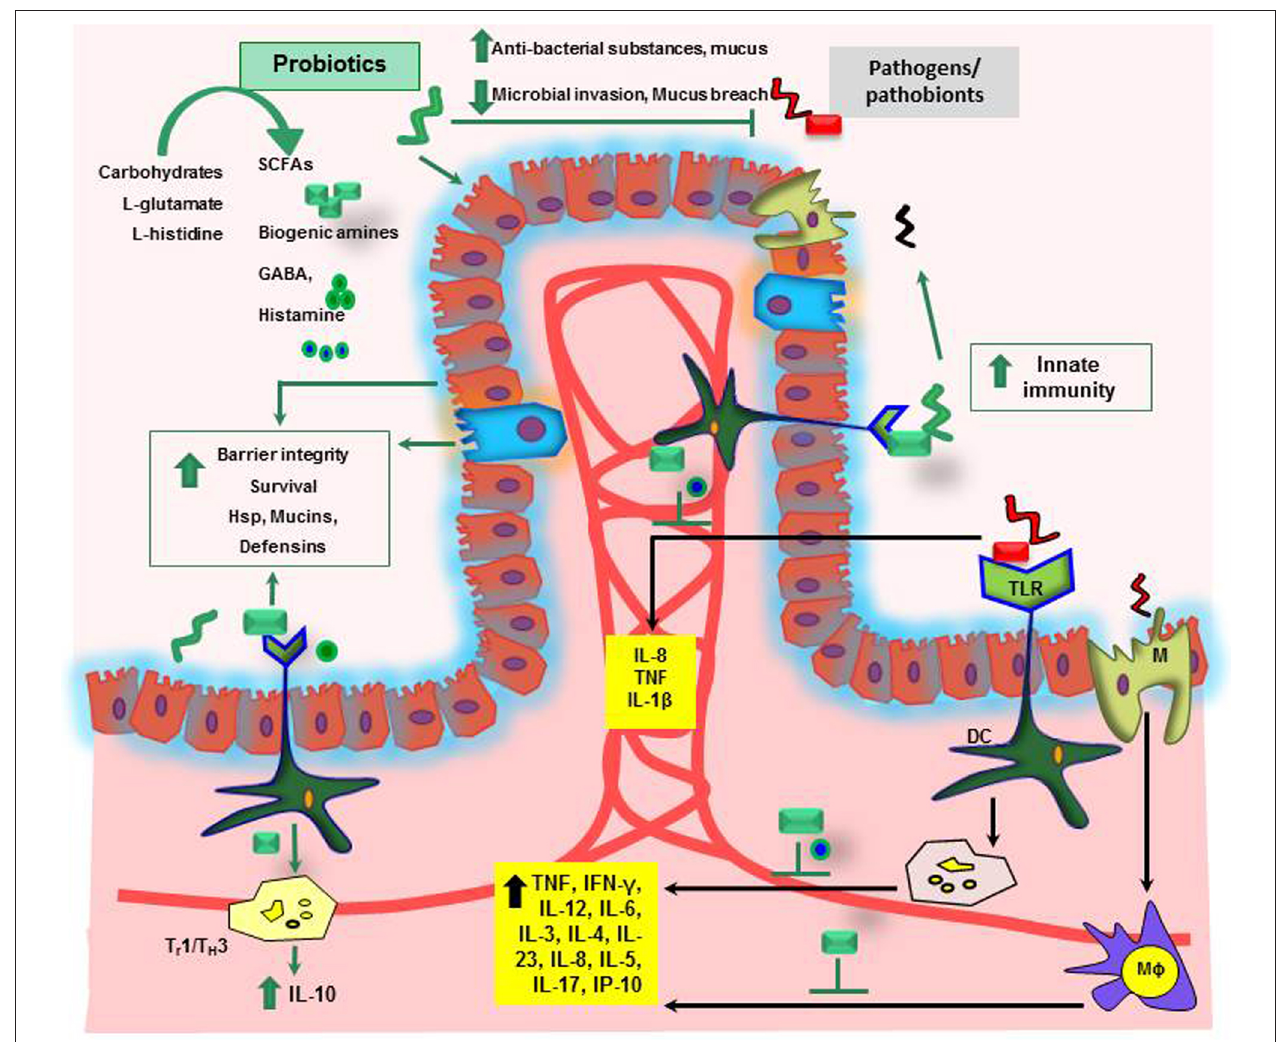
FIGURE 2 | Mechanisms of probiosis in the gastrointestinal tract. SCFAs, short chain fatty acids; GABA, gamma-aminobutyric acid; Hsp, heat shock proteins; IL, interleukin; TNF, tumor necrosis factor; Th, T-helper; IFN- γ , interferon gamma; M ϕ , Macrophage; DC, dendritic cell; M, microfold